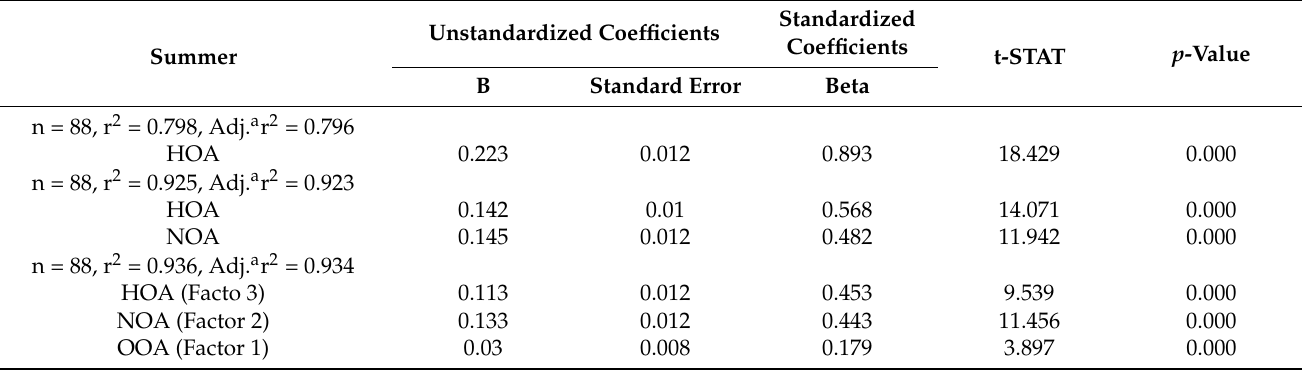
Table 5. Multiple linear regression between DTT v and individual source contribution resolved by PMF to WSOA in